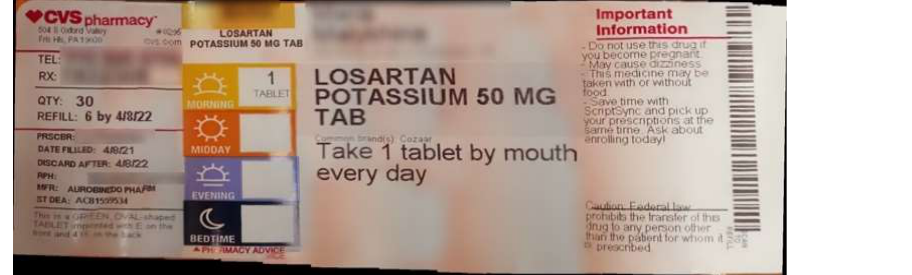
Figure 8. Stitched Label.